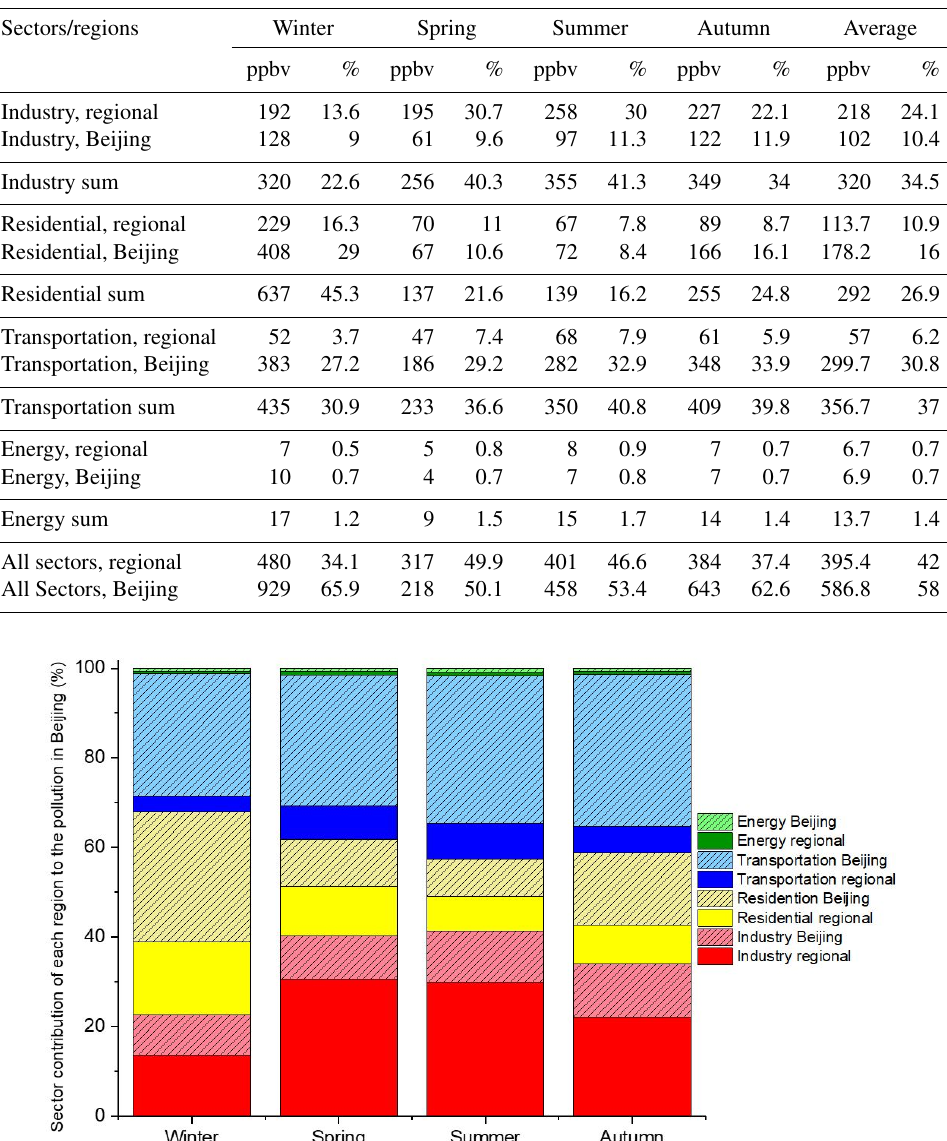
Table 2. Sector CO pollution contribution to Beijing from each region.